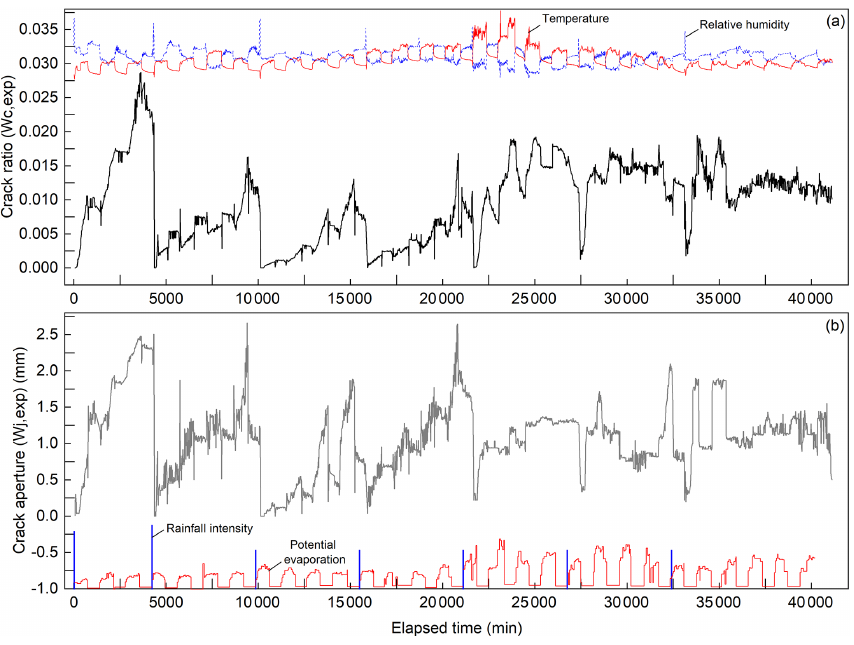
Figure 6. Time series of crack geometries. (a) Crack ratio. (b) Crack aperture.